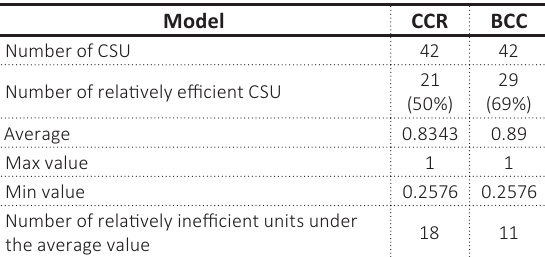
Table 2. Efficiency results concerning basic models